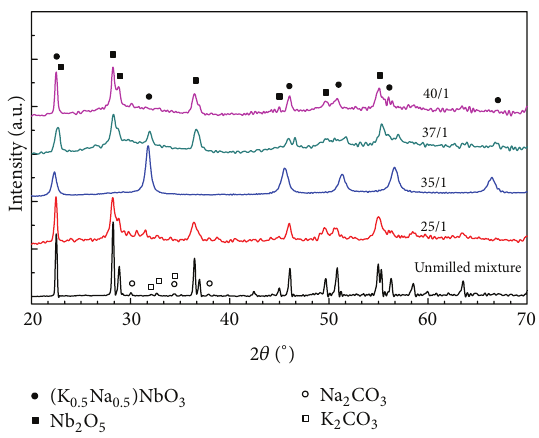
Figure 1: X-ray diffraction diagrams of unmilled mixture and as- milled (K 0.5 Na 0.5 )NbO 3 prepared mechanochemically at 600rpm for 5 h with different ball-to-powder mass ratios of 25/1, 35/1, 37/1, and 40/1.